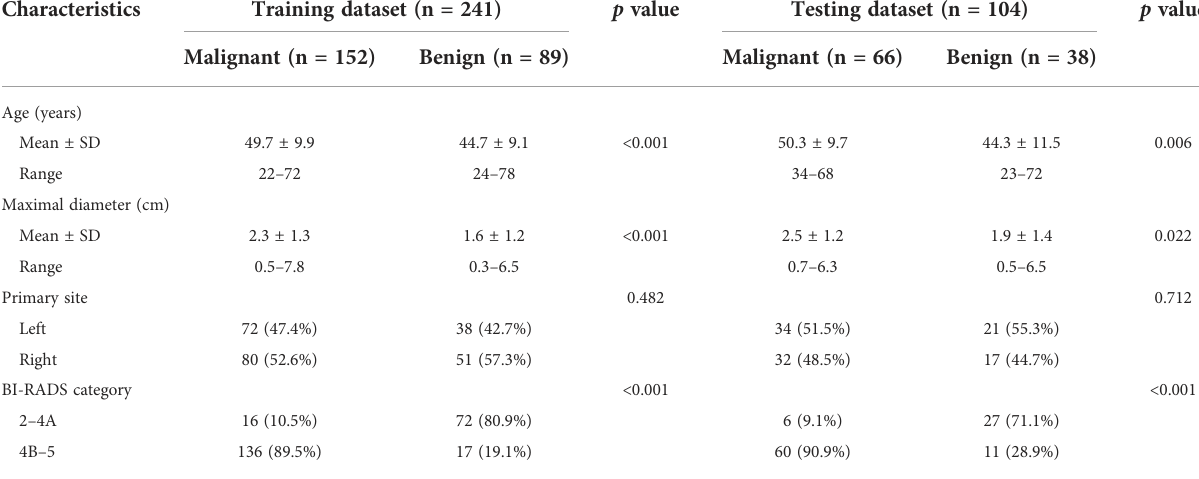
TABLE 1 Characteristics of breast lesions from corresponding patients in the training and testing datasets.